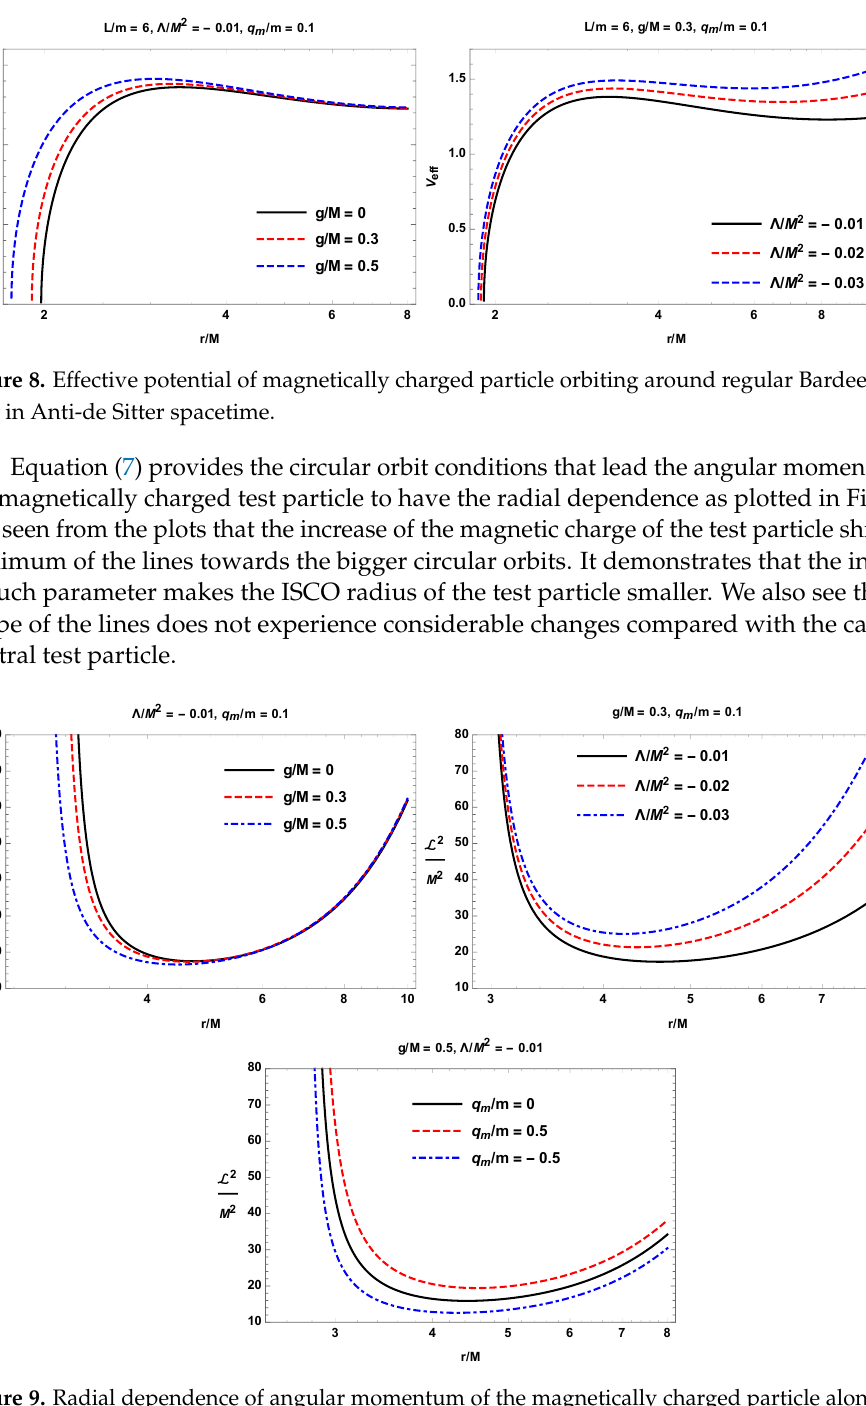
Figure 9. Radial dependence of angular momentum of the magnetically charged particle along circu- lar orbits at the equatorial plane around the regular Bardeen black hole in Anti-de Sitter